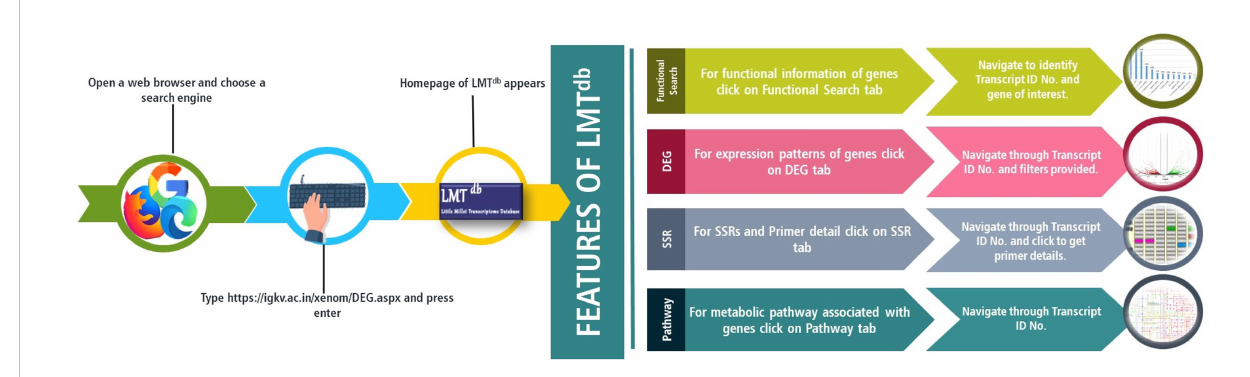
FIGURE 3 Schematics regarding access, browse and search gene functions in Little Millet transcriptome database (LMT db